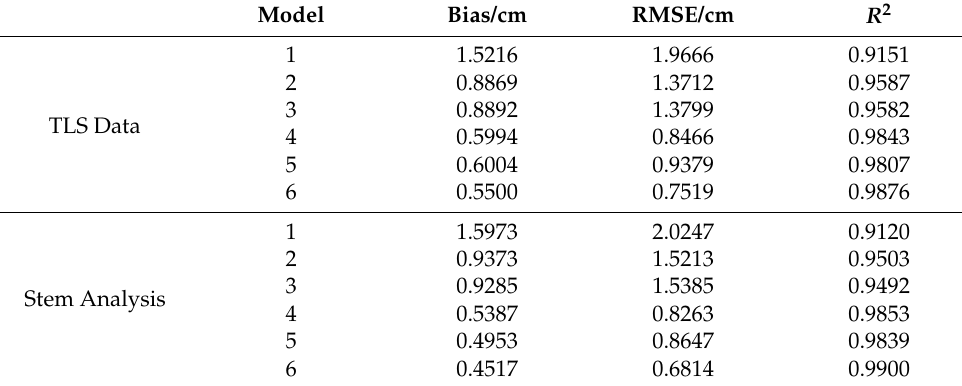
Table 4. Fitting statistics of the taper